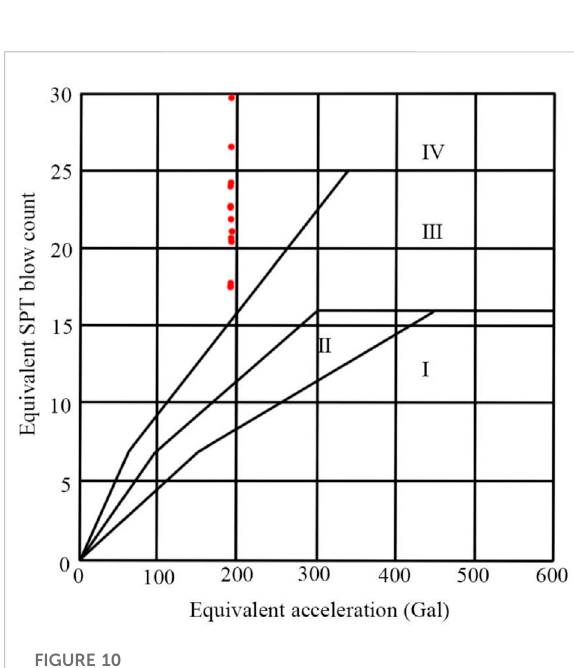
FIGURE 10 Liquefaction discrimination zoning of H1 to H5, BH1 and BH2 drilling samples based on